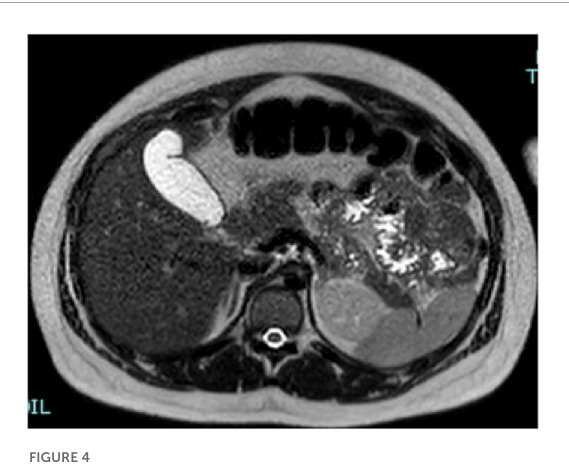
FIGURE4 A representative image of adrenal glands with magnetic resonance imaging. After 4 weeks, the adrenal glands show normal shape, margins, and signal intensity in T2 axial view images. The film fluid was